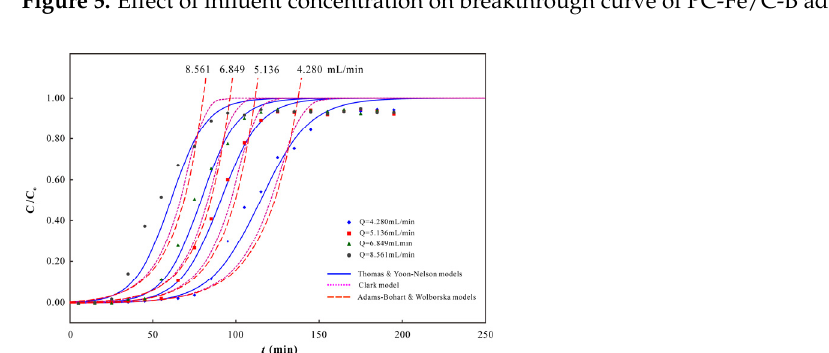
Figure 6. Effect of influent flow rate on breakthrough curve of PC ‐ Fe/C ‐ B adsorption As(V).